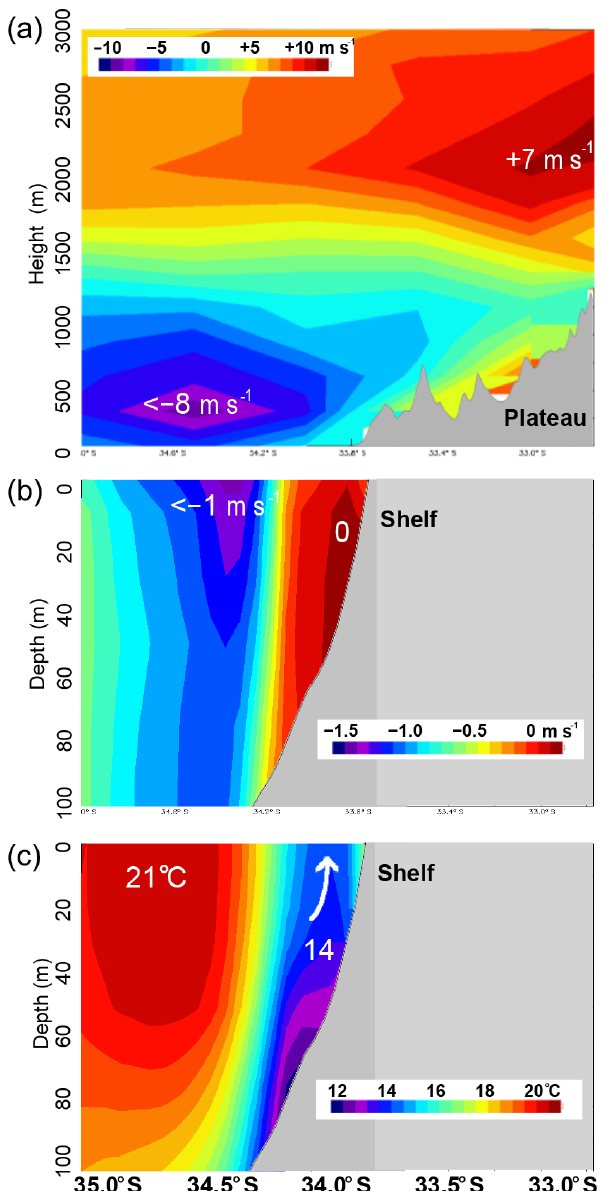
Figure 5. Vertical N–S sections on 26 ◦ E averaged during 15 October–5 November 2014 of (a) MERRA2 zonal wind, (b) HY- COM zonal current, and (c) sea temperature.